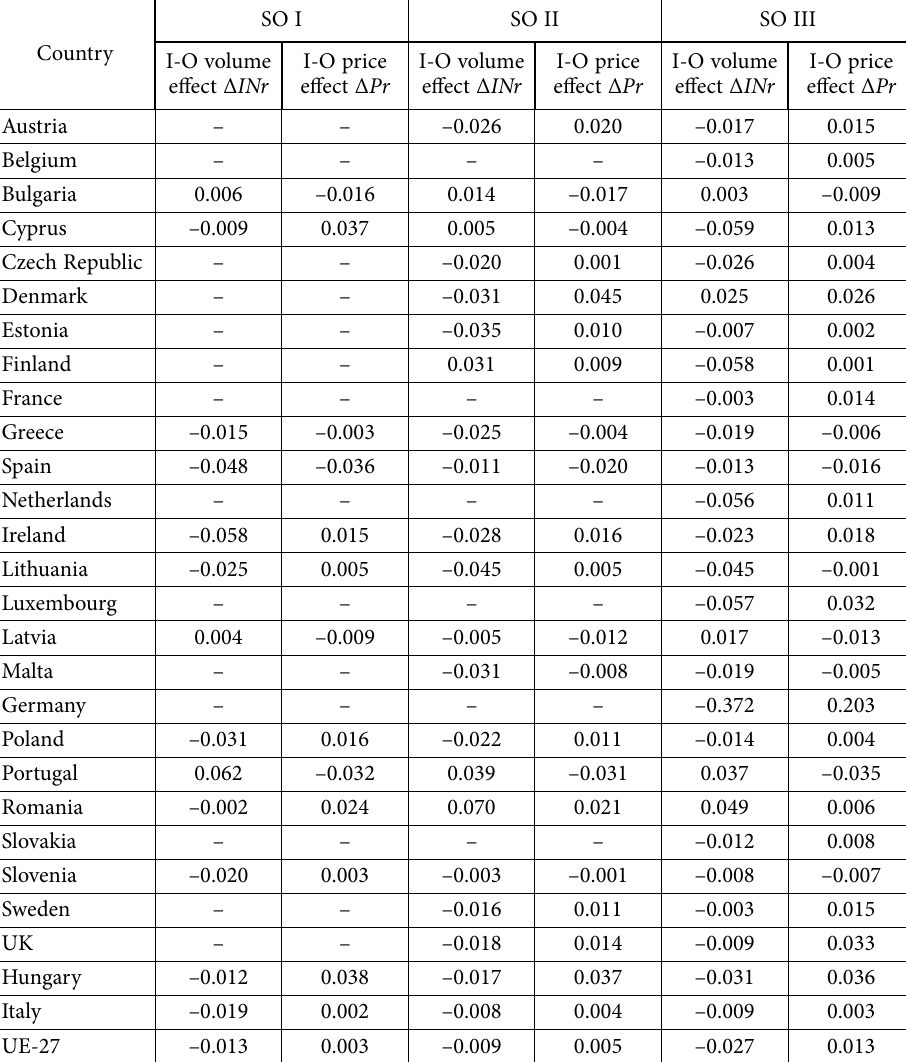
Table 2. Descriptive statistics: decomposition of price and volume effect in € related to output; year averages in 2004–2012 in the range of different economic size of farms (SO I - SO III) (source: own calculations using EU FADN dat and EAA Eurostat prices)